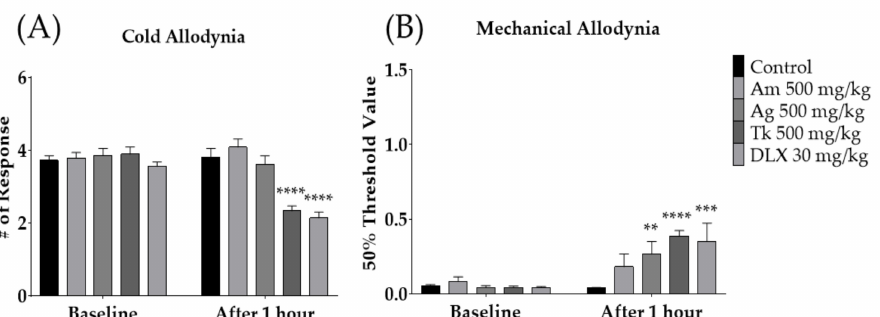
Figure 4. Effect of SH003 components on paclitaxel-induced cold and mechanical allodynia ( A , B ). Behavioral tests were conducted before and 1 h after the oral treatment of Am, As, Tk, DLX and PBS in mice. PBS was administered as a control to Am, Ag, Tk, and DLX. DLX was intraperitoneally injected as a positive control. Am: Astragalus membranaceus , Ag: Angelica gigas , Tk: Trichosanthes kirilowii Maximowicz, DLX: Duloxetine. Control: n = 13, Am 500 mg/kg: n = 6, Ag 500 mg/kg: n = 6, Tk 500 mg/kg: n = 6, DLX 30 mg/kg: n = 6. ** p < 0.01, *** p < 0.001, **** p < 0.0001 vs. Baseline with two-way ANOVA followed by Sidak’s post-test for multiple